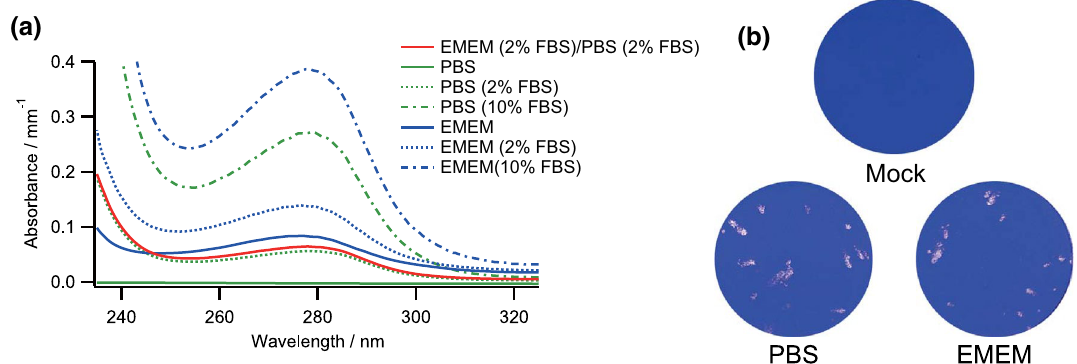
Figure 1. Effects of the culture media on light absorbance and SARS-CoV-2 infectivity. ( a ) Absorbance spectra of EMEM, FBS, PBS, and their mixed media. The absorbance by the various media indicated was monitored using a UV–visible spectrometer. FBS concentrations in the culture media are shown in parentheses. EMEM (2% FBS)/PBS (2% FBS), red line; EMEM containing 2% FBS diluted with PBS containing 2% FBS by tenfold. ( b ) Effects of the culture media on viral infectivity. Virus samples were diluted with EMEM containing 2% FBS (EMEM) or PBS containing 2% FBS (PBS). The samples appropriately diluted for plaque assays were inoculated into Vero E6 cells. On day 3 post-infection, cells were fixed and stained to visualize plaques. Representative data from six independent assays are